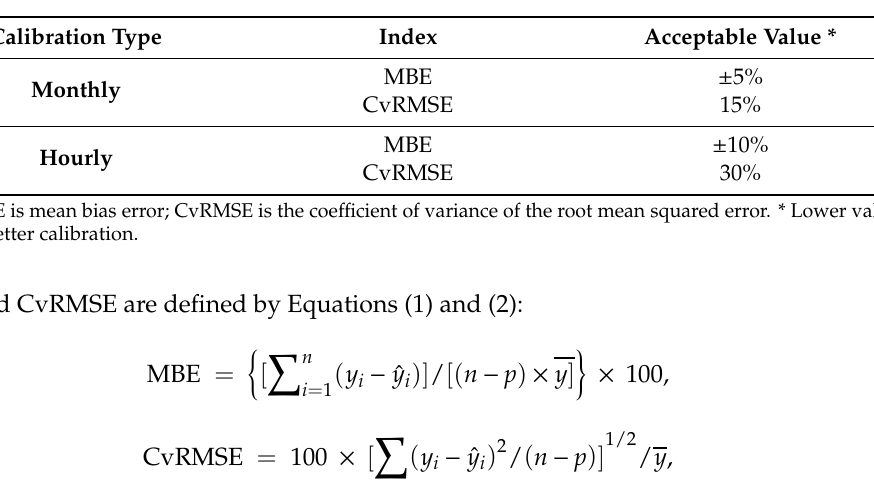
Table 5. Acceptable calibration